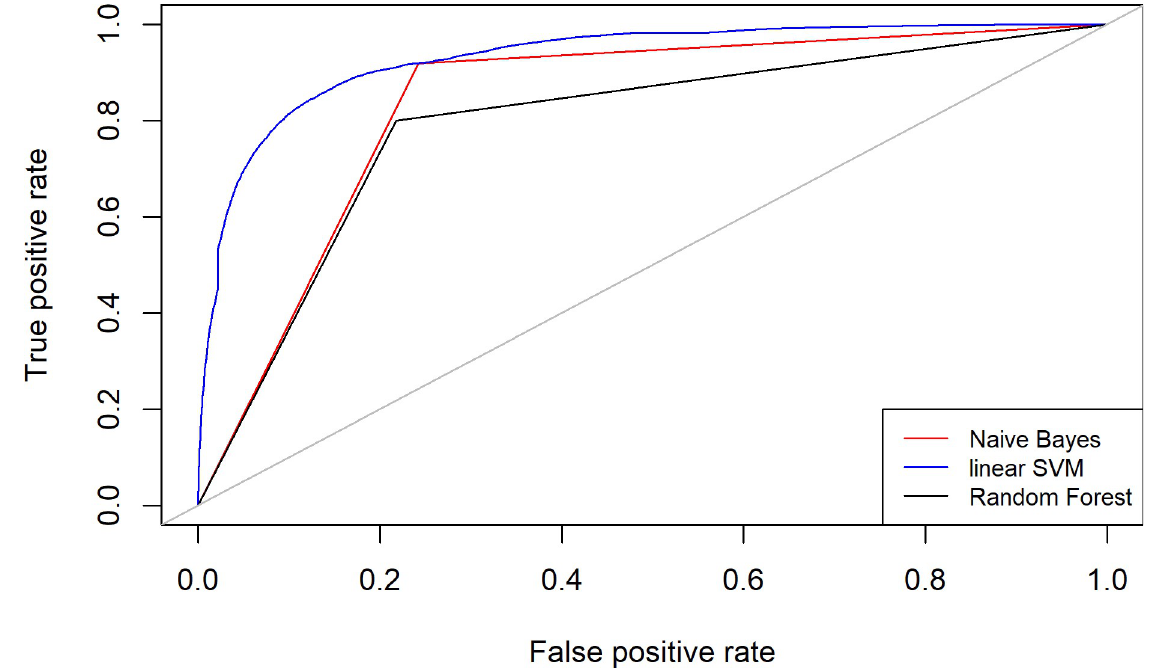
Fig 12. ROC curves for accurately identifying members of the tech elite from the general Twitter